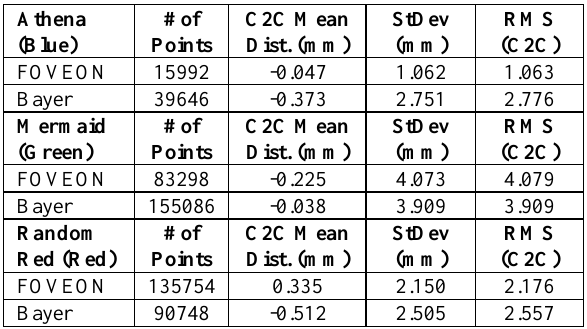
Table 7: Mean Distance, Standard Deviation and RMS error of Red, Green and Blue classified points for every respective site.